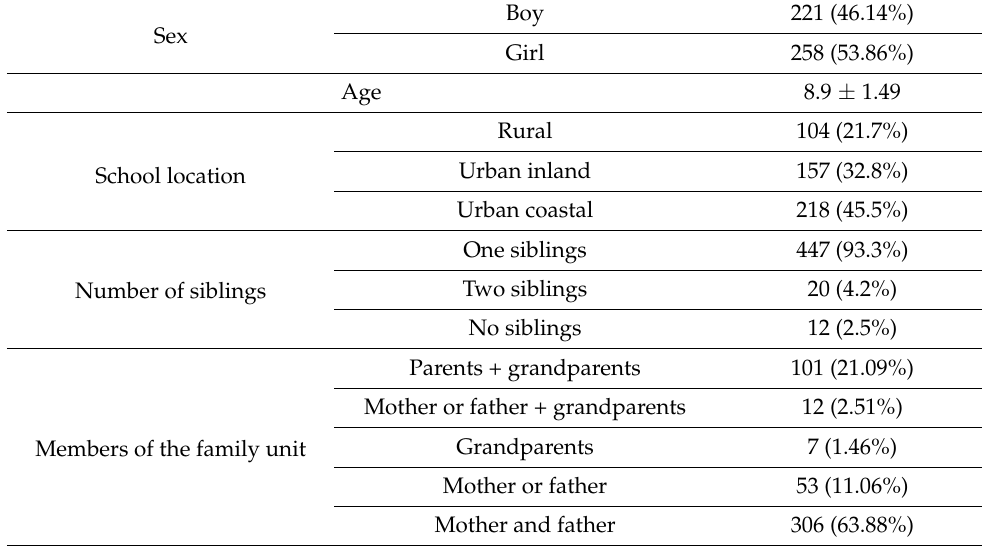
Table 1. Description of the population participating in the